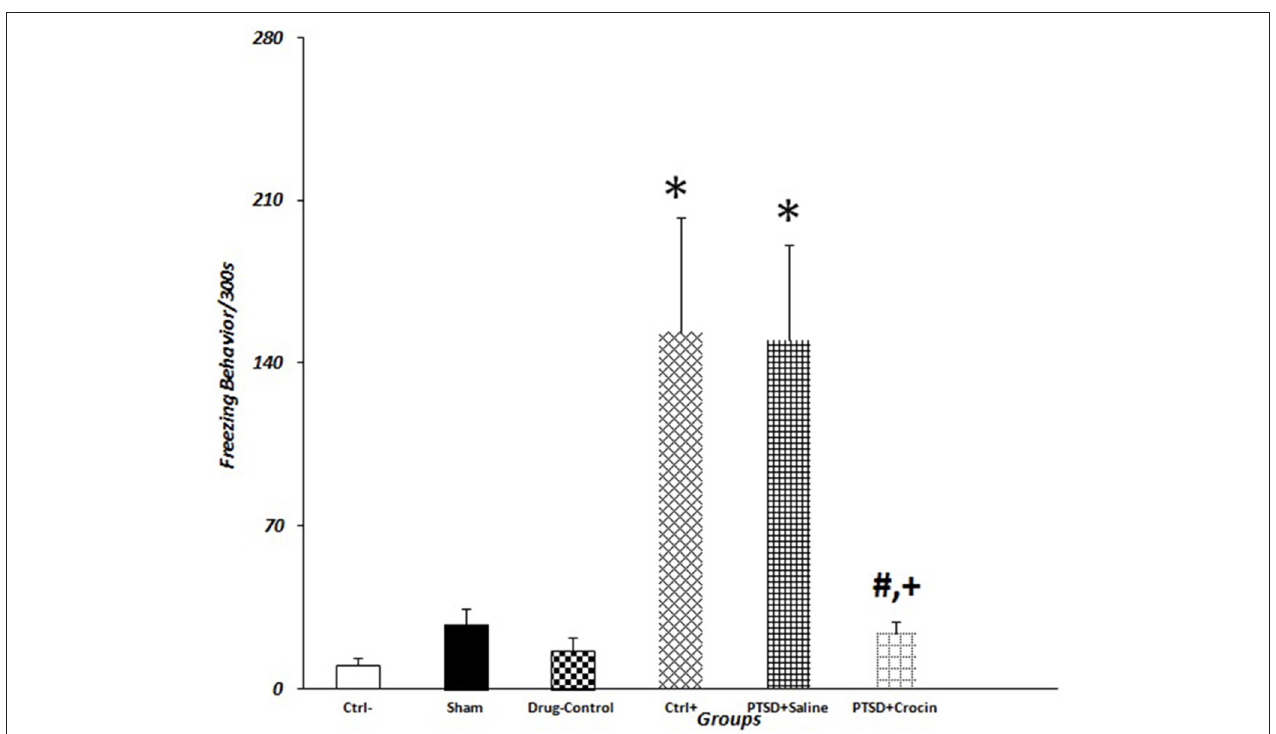
FIGURE 3 | Data are shown as mean ± SEM, n = 8 per groups. Exploratory behavior was measured on day 21 post-shock at the re-exposure time, and freezing behaviors were quantified. * P < 0.05 showed a significant increase in freezing time in positive control and the PTSD + saline groups compared to the negative control group. + P < 0.05 and # P < 0.05 showed a significant decrease in freezing time in the PTSD + Crocin group compared to the positive control and the PTSD + saline groups, respectively.